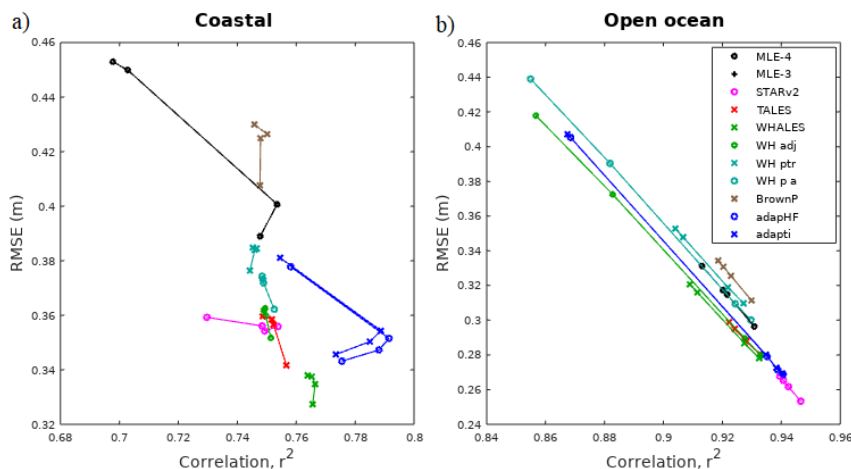
Figure 6. Generally improved performance as minimum no. of valid measurements is increased from 1 (at top left with low r 2 and high RMSE) to 5 to 10 to 20. Results are displayed for the various different Jason-3 algorithms for ( a ) Coastal zone (buoy within 15 km of coastline), ( b ) Open ocean. In most cases, more observations leads to higher r 2 and lower RMSE. (The chosen areas for these plots do not show MLE-3, which had much lower r 2 values and higher RMSE than the other algorithms.)